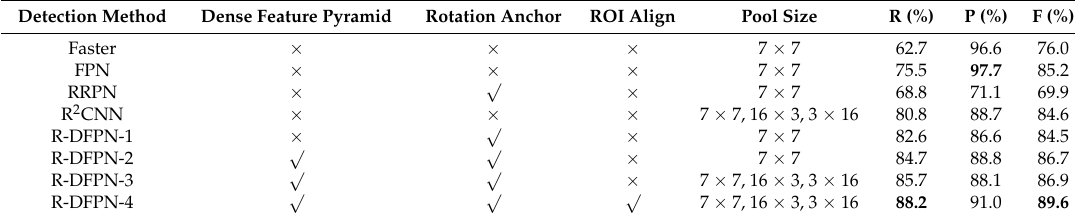
Table 1. Comparison of the performance of each detection method under the confidence score threshold of 0.5 (based on FPN frameworks, except Faster-RCNN). R, P, F represent Recall, Precision, and F-measure, respectively. Bold numbers are the highest indicator values of all methods.